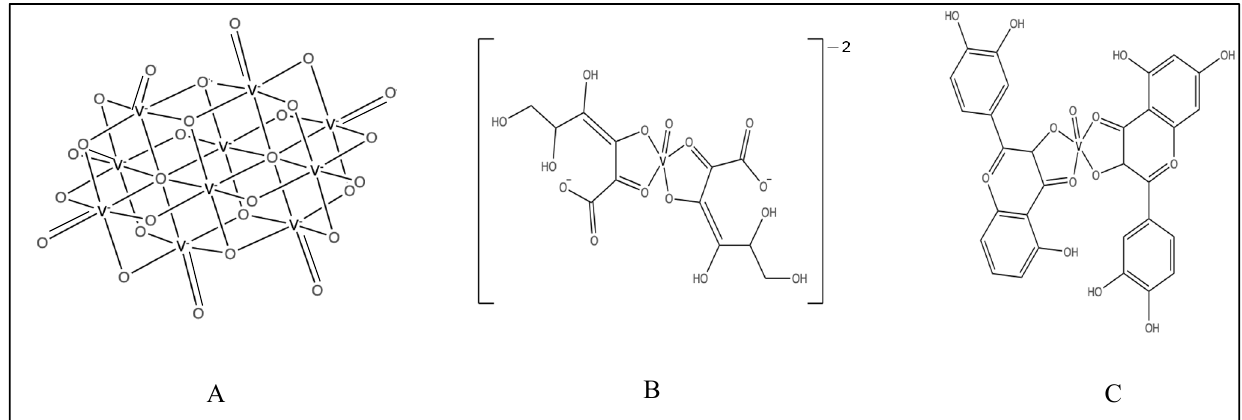
Figure 4. Structures of vanadium complexes of ( A ) decavanadate, ( B ) 2,3-diketogulonic acid, and ( C ) quercetin.